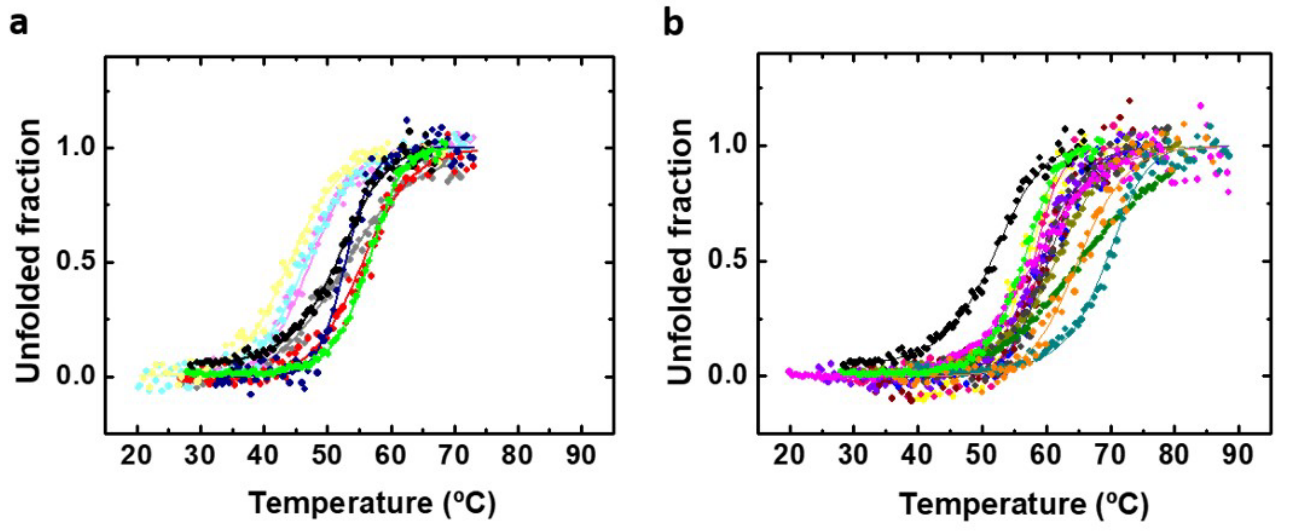
Figure 2. In vitro effects of IV PC and IVx analogues on PAH thermostability. Thermal unfolding curves of PAH in absence or presence of IV PC and ( a ) IVx analogues with thermodestabilizing or moderate effect or ( b ) with thermostabilizing effect. The samples contain PAH (2 µM monomer concentration) and 100 µM compound IV PC (green), IVa (yellow), IVb (gray), IVc (pink), IVd (blue), IVe (brown), IVf (red), IVg (violet), IVh (light magenta), IVi (olive), IVj (light cyan), IVk (light yellow), IVl (navy), IVm (ochre), IVn (orange), IVo (dark gray), IVp (turquoise) and IVq (magenta). Control in absence of compound (black) contains the same % of DMSO as the rest of samples. Continuous lines correspond to two-state fittings of the unfolding curves.